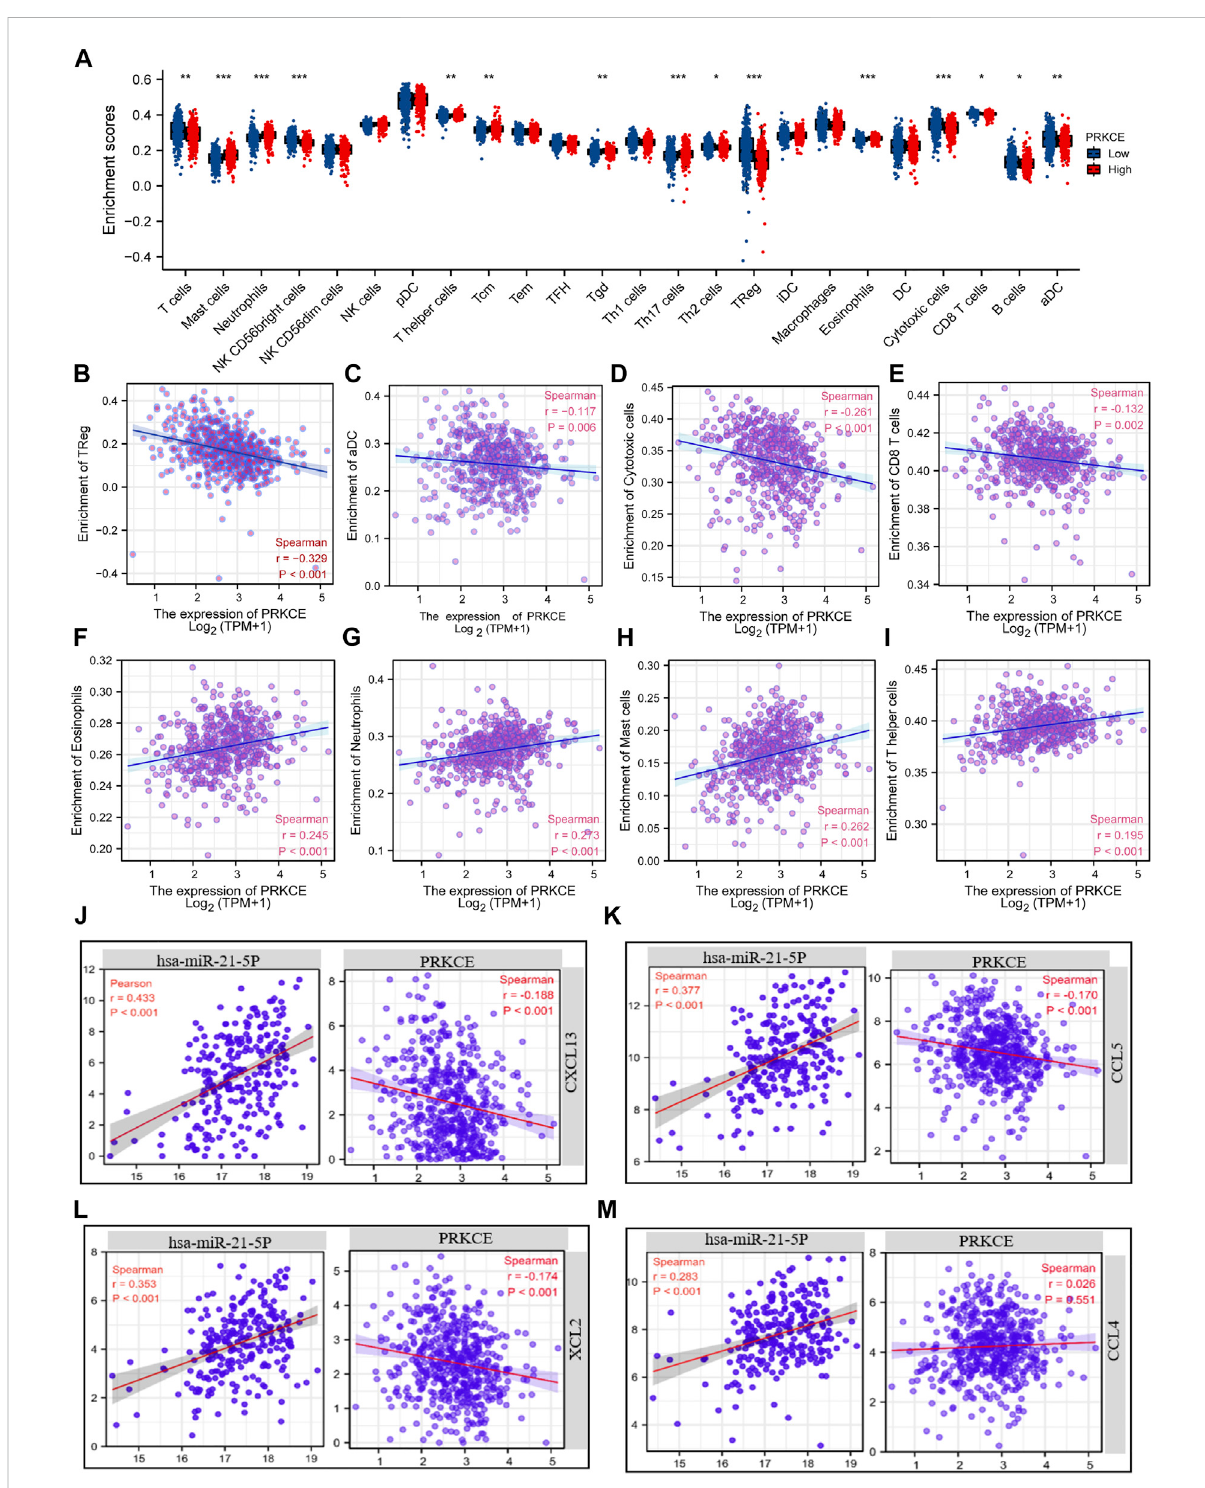
FIGURE 6 Chemokines mediated the regulatory effects of PRKCE on immune cell in fi ltration. (A) Proportions of the 24 tumor-in fi ltrating immune cell types in low and high expression groups of PRKCE. (B – E) PRKCE expression signi fi cantly negatively correlates with in fi ltrating levels of (B) Treg, (C) aDC, (D) Cytotoxic, and (E) CD8 T cells. (F – I) PRKCE expression signi fi cantly positively correlates with in fi ltrating levels of (F) Eosinophils, (G) Neutrophils, (H) Mastcells, and (I) Thelper cells. (J – M) Pearson ’ scorrelation analysis wasapplied to explore therelationshipsbetween thehsa- miRNA-21-5p/PRKCE axis and 4 Chemokines (CXCL13, CCL5, XCL2, and